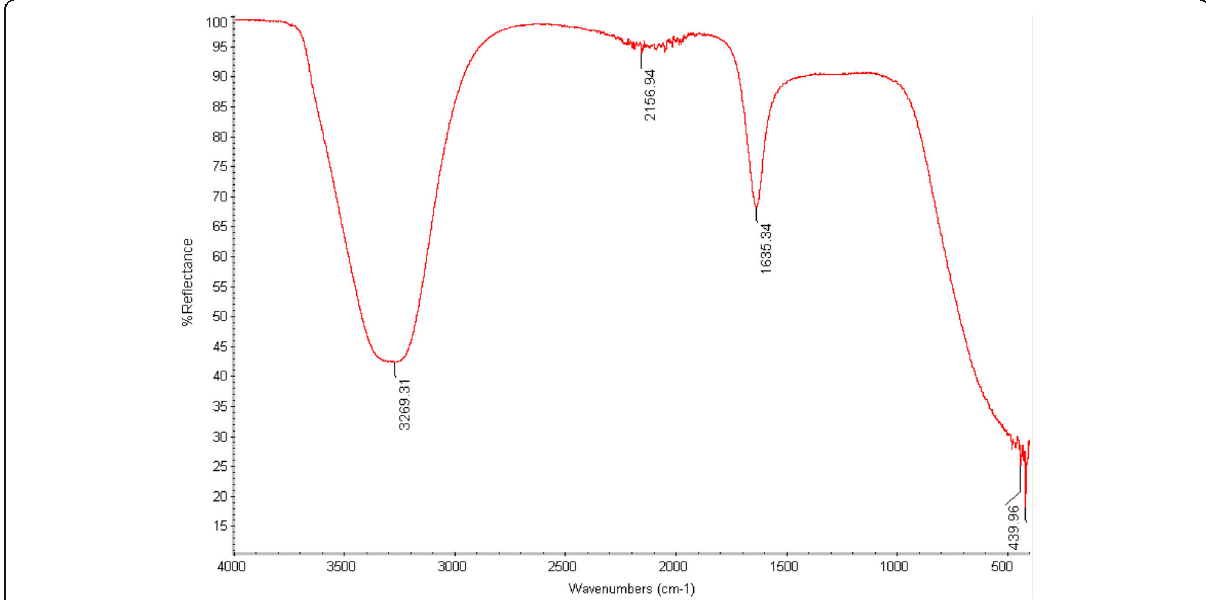
Fig. 5 Fourier transform infrared spectroscopy (FTIR) spectrum of AgNPs synthesized by reduction of Ag + ions by Trichoderma